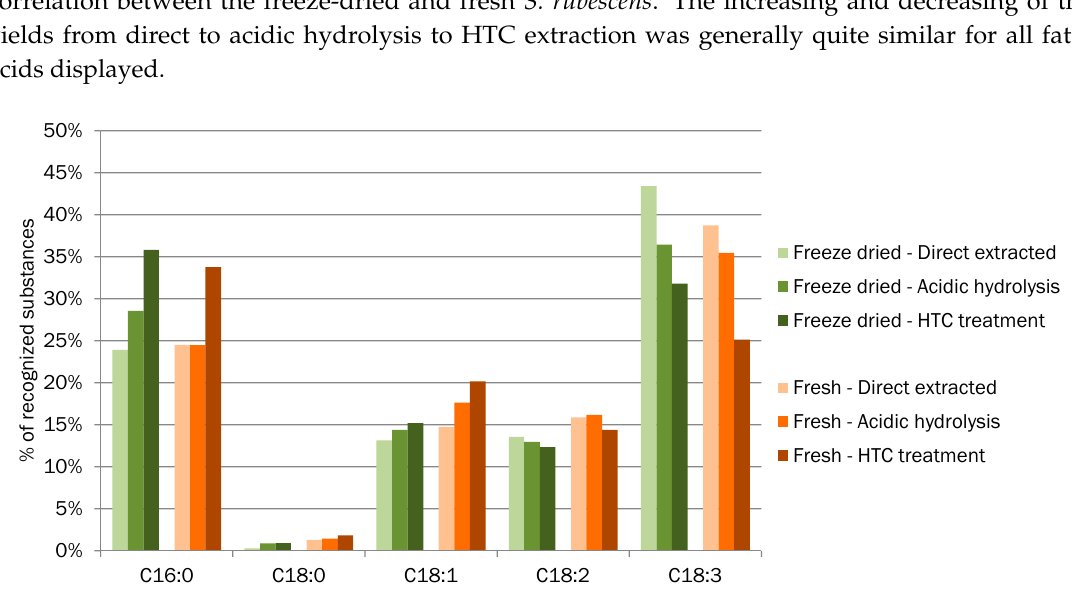
Figure 3. Main fatty acid percentage of the sum of recognized fraction for S. rubescens .